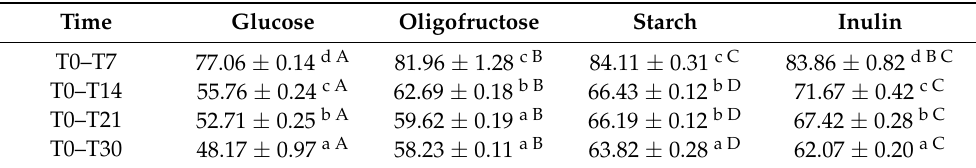
Table 3. Impact of shelf life on the survival rate of probiotic strains. T = time in days, T0–T7, T0–T14, T0–T21, T0–T30—storage times between which the survival rate was calculated. Time